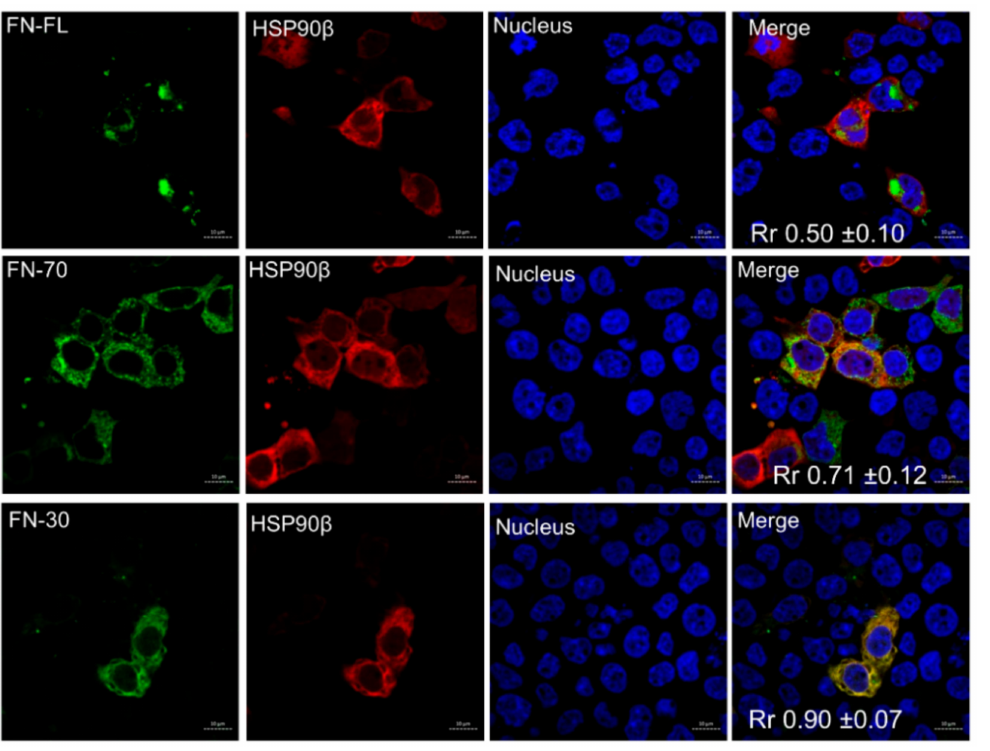
Figure 3. HSP90 and fibronectin fragments colocalize in cells. Colocalization analysis of mCherry-HSP90 β (red) and full-length FN-YPET, FN30-EGFP, and FN70-EGFP (green) by confocal microscopy. Scale bar is 10 µ m and data shown are representative of independent biological triplicate experiments. The Rr shows the average Pearson’s correlation coe ffi cient ( ± SD, n ≥ 3) between HSP90 and FN